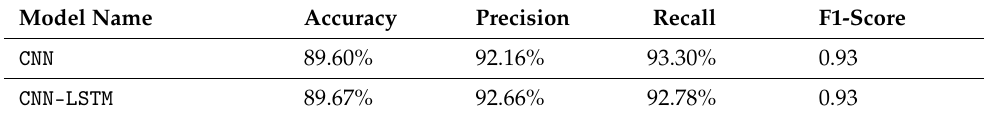
Table 6. Results of CNN